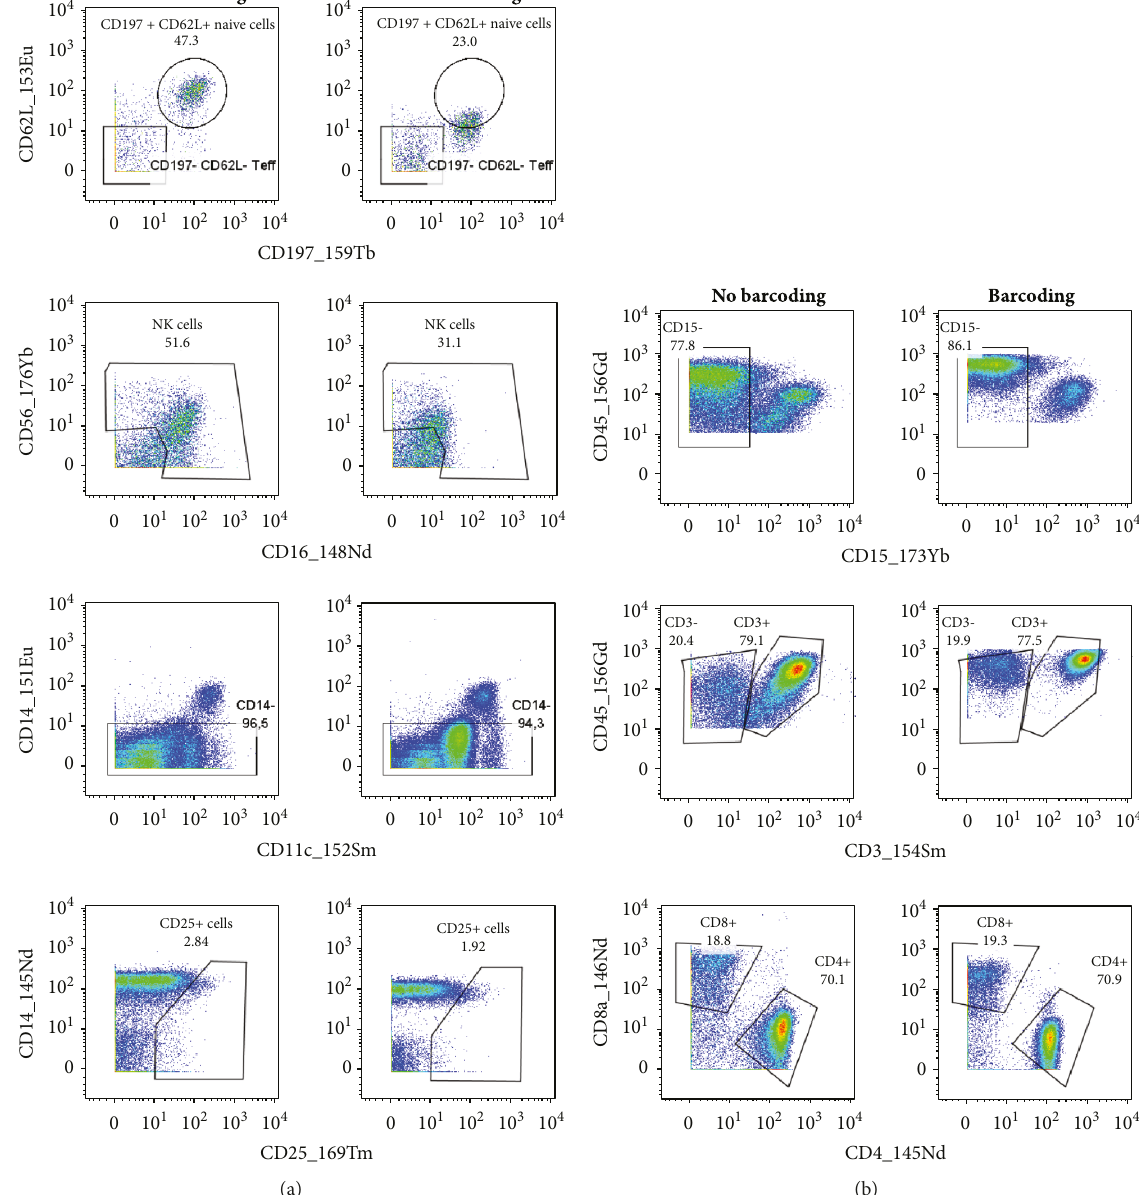
Figure 2: Stability of several antigens was a ff ected by Pd-based barcoding. Ficoll-isolated PBMCs from a healthy donor were stained for live and dead cells and halved. One part of the cells was barcoded with the Cell-ID 20-Plex Pd Barcoding Kit, and the rest of the cells were used as a control without barcoding. Subsequently, the cells were stained with the designed panel of antibodies. The labeled cells were stored in the intercalator solution until measurement on CyTOF. After measurement, the barcoded cells were debarcoded according to the labeling pattern of the barcoding kit. (a) Markers with reduced intensity and (b) cell populations become more evident after Pd barcoding. The same gates (adjusted for the cells without barcoding) were applied to measured